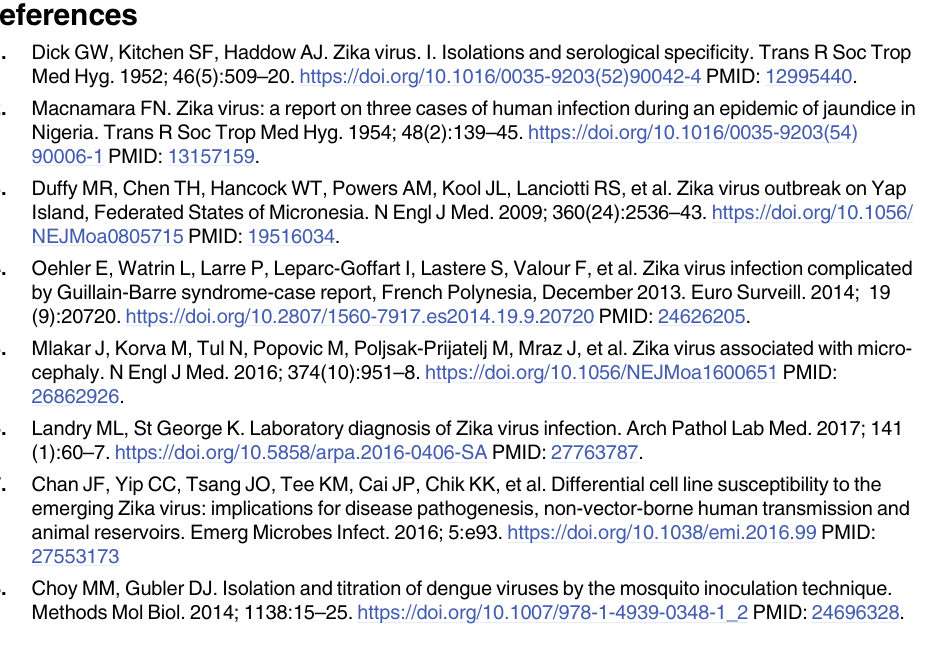
S1 Fig. The plaque sizes of 8 ZIKV isolates; (A) MU-DMSC-2/2016, (B) MU-DMSC-3/2016, (C) MU-DMSC-4/2016, (D) MU-DMSC-5/2016, (E) MU-DMSC-2/2017, (F)